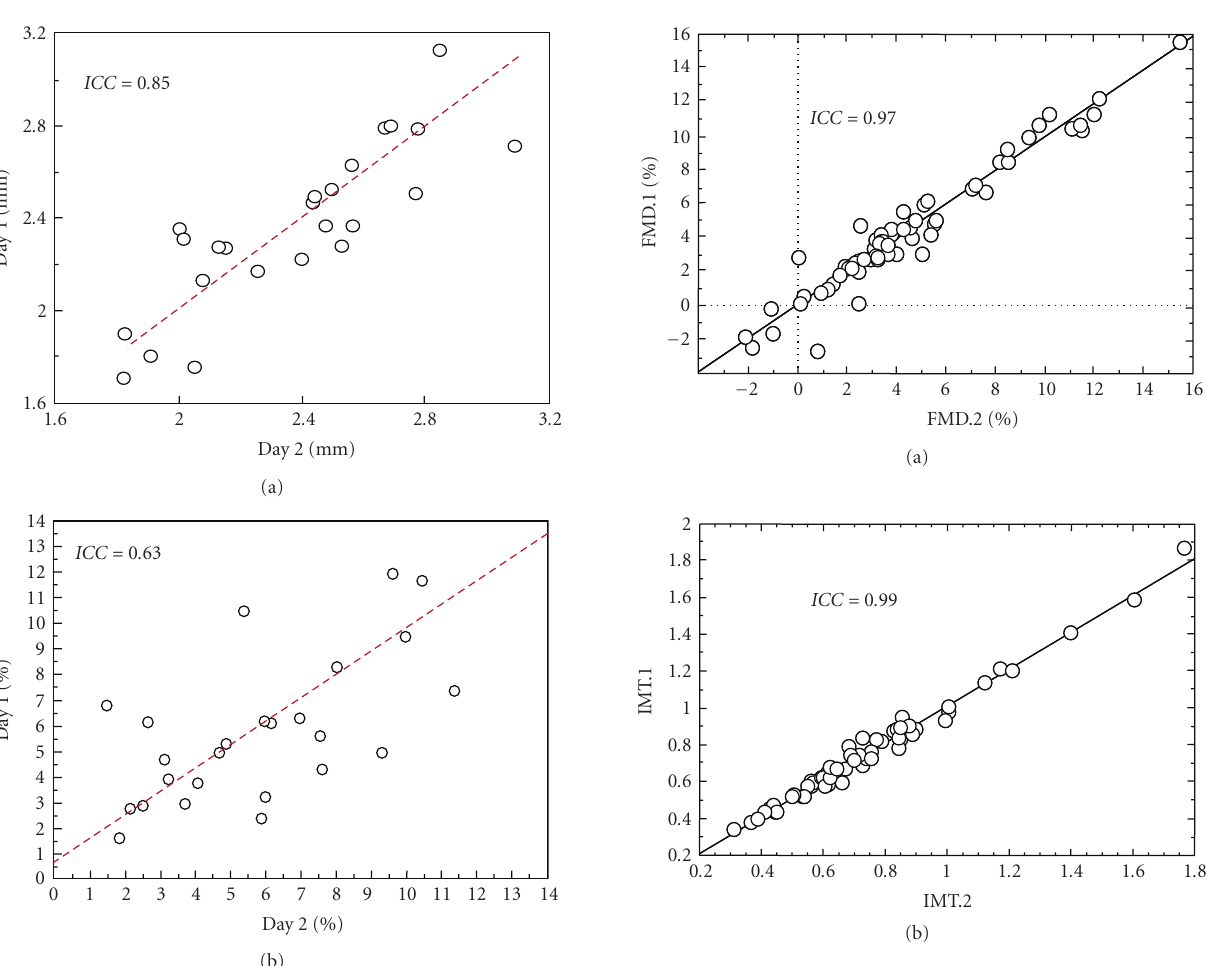
Figure 7: Repeatability. (a) FMD; (b)